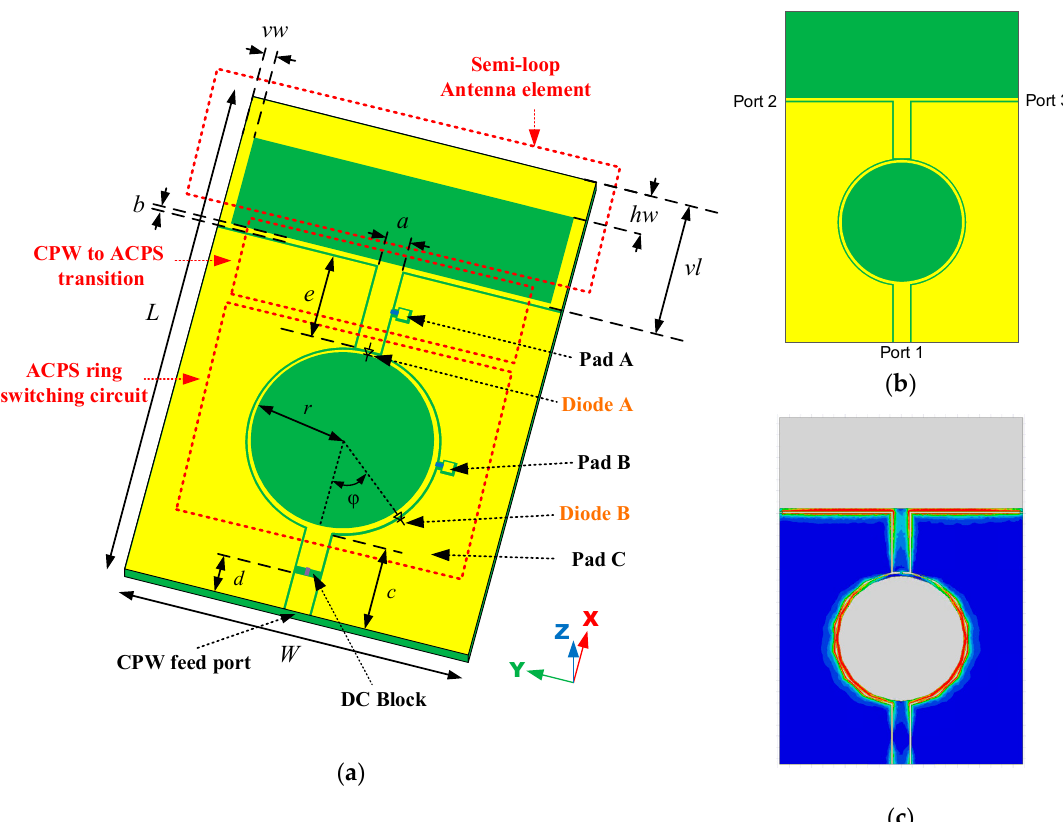
Figure 1. Geometry of the proposed antenna: ( a ) antenna structure; ( b ) coplanar waveguide (CPW) to asymmetric coplanar strip line (ACPS) transition; and ( c ) simulated surface current distribution of the transmission line structure. Table 1. Optimized antenna dimensions.